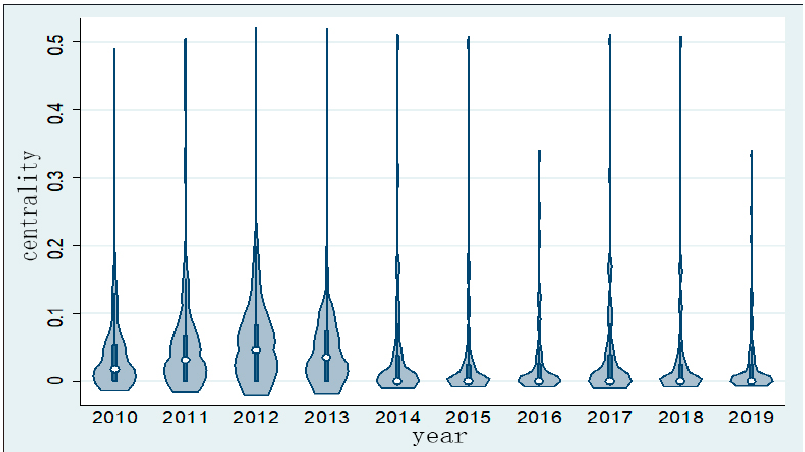
Figure 5. Violin diagram of knowledge-based network centrality .